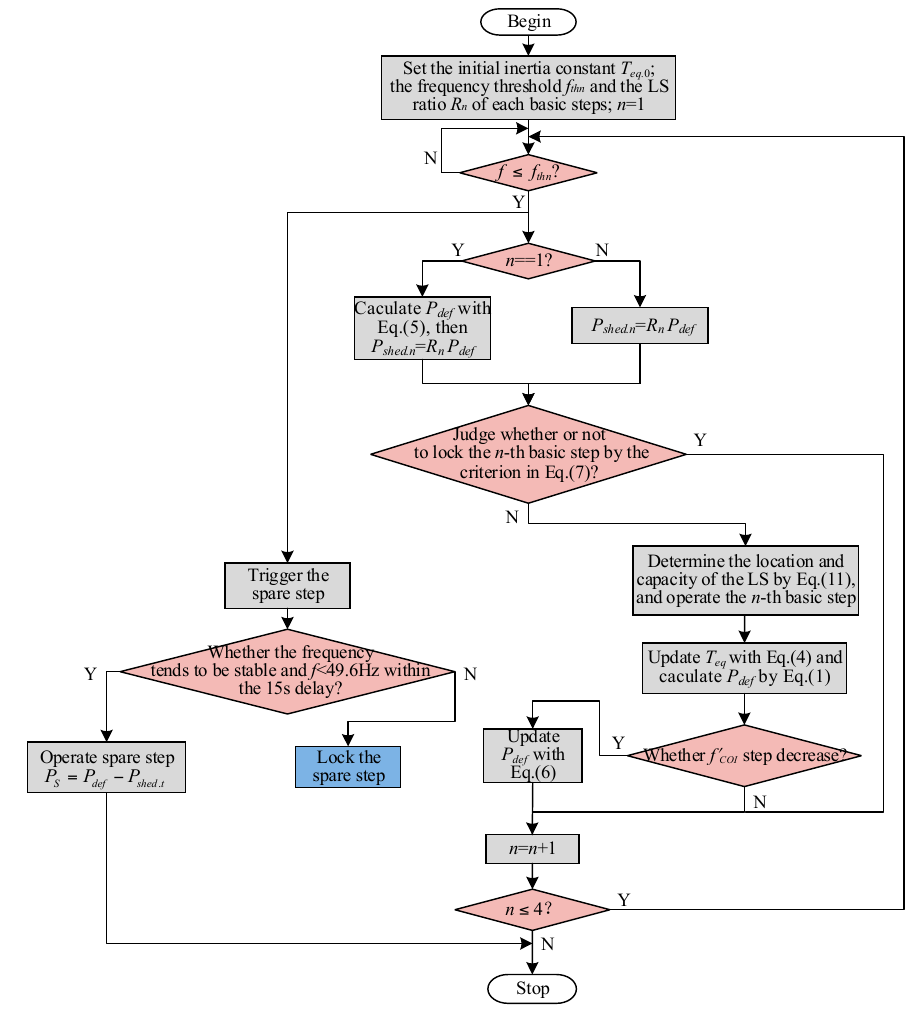
Figure 3. Flowchart of the load shedding scheme.